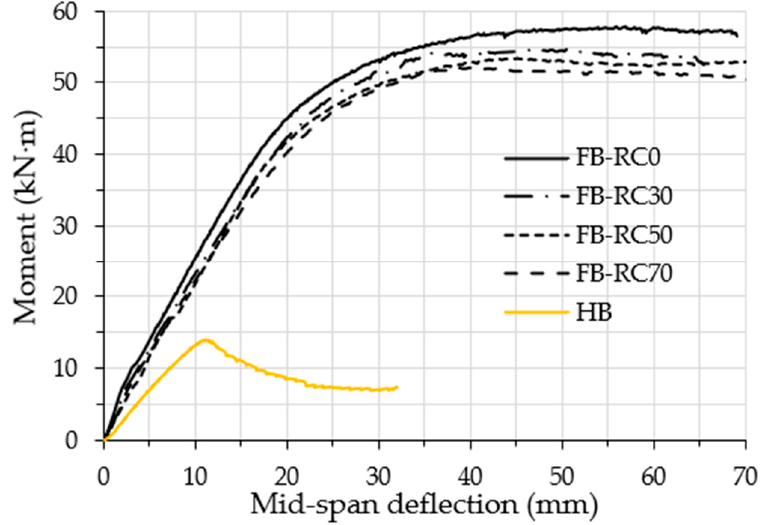
Figure 5. Moment vs. mid-span deflection relationships.